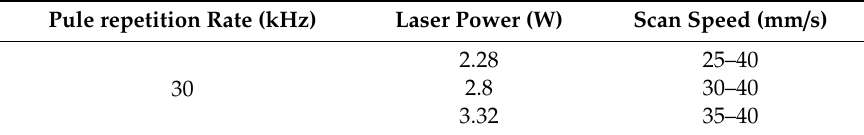
Table 5. Process condition for the crack-free groove.